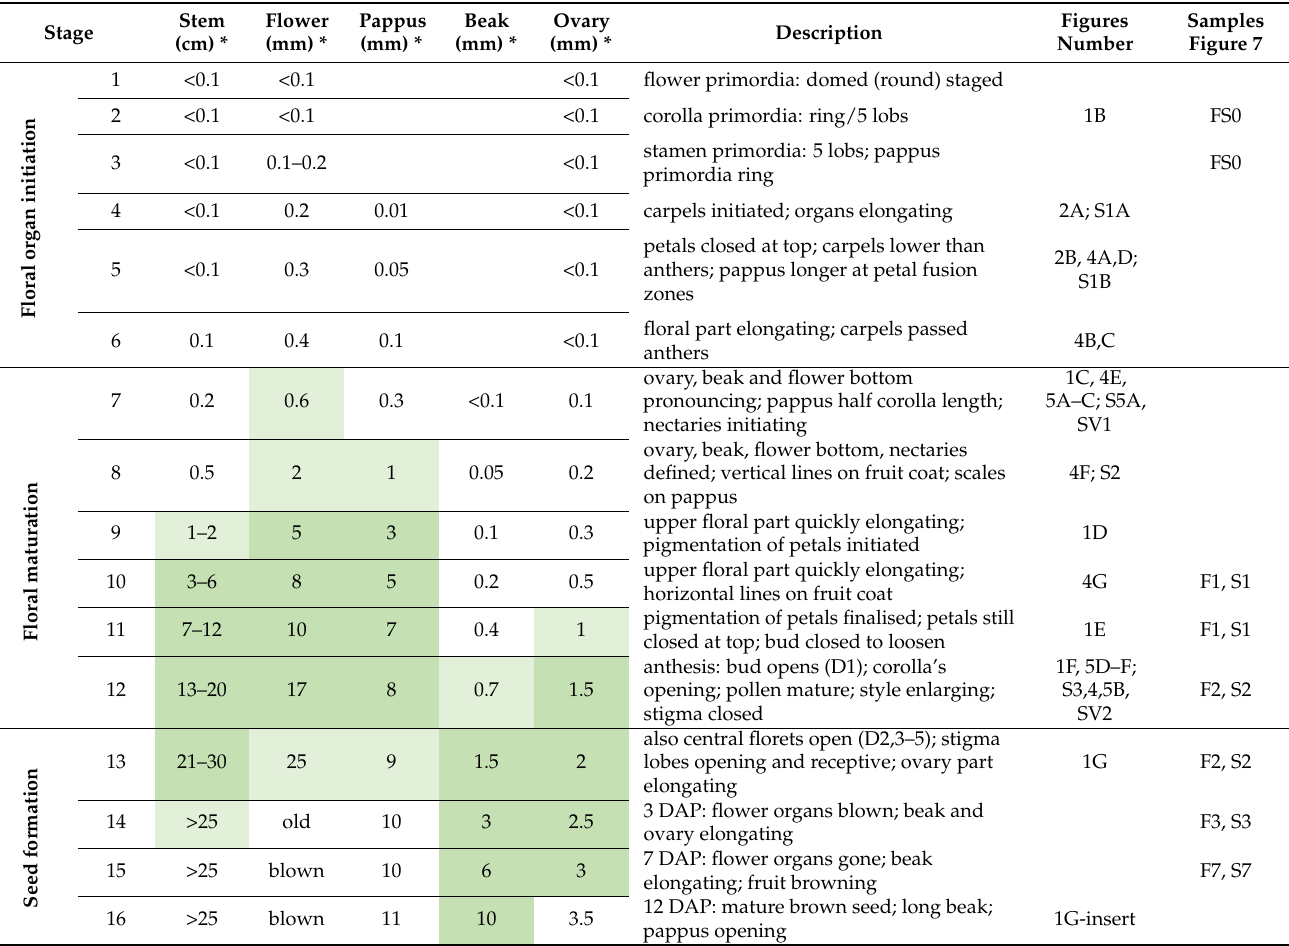
Table 1. Floral developmental stages of